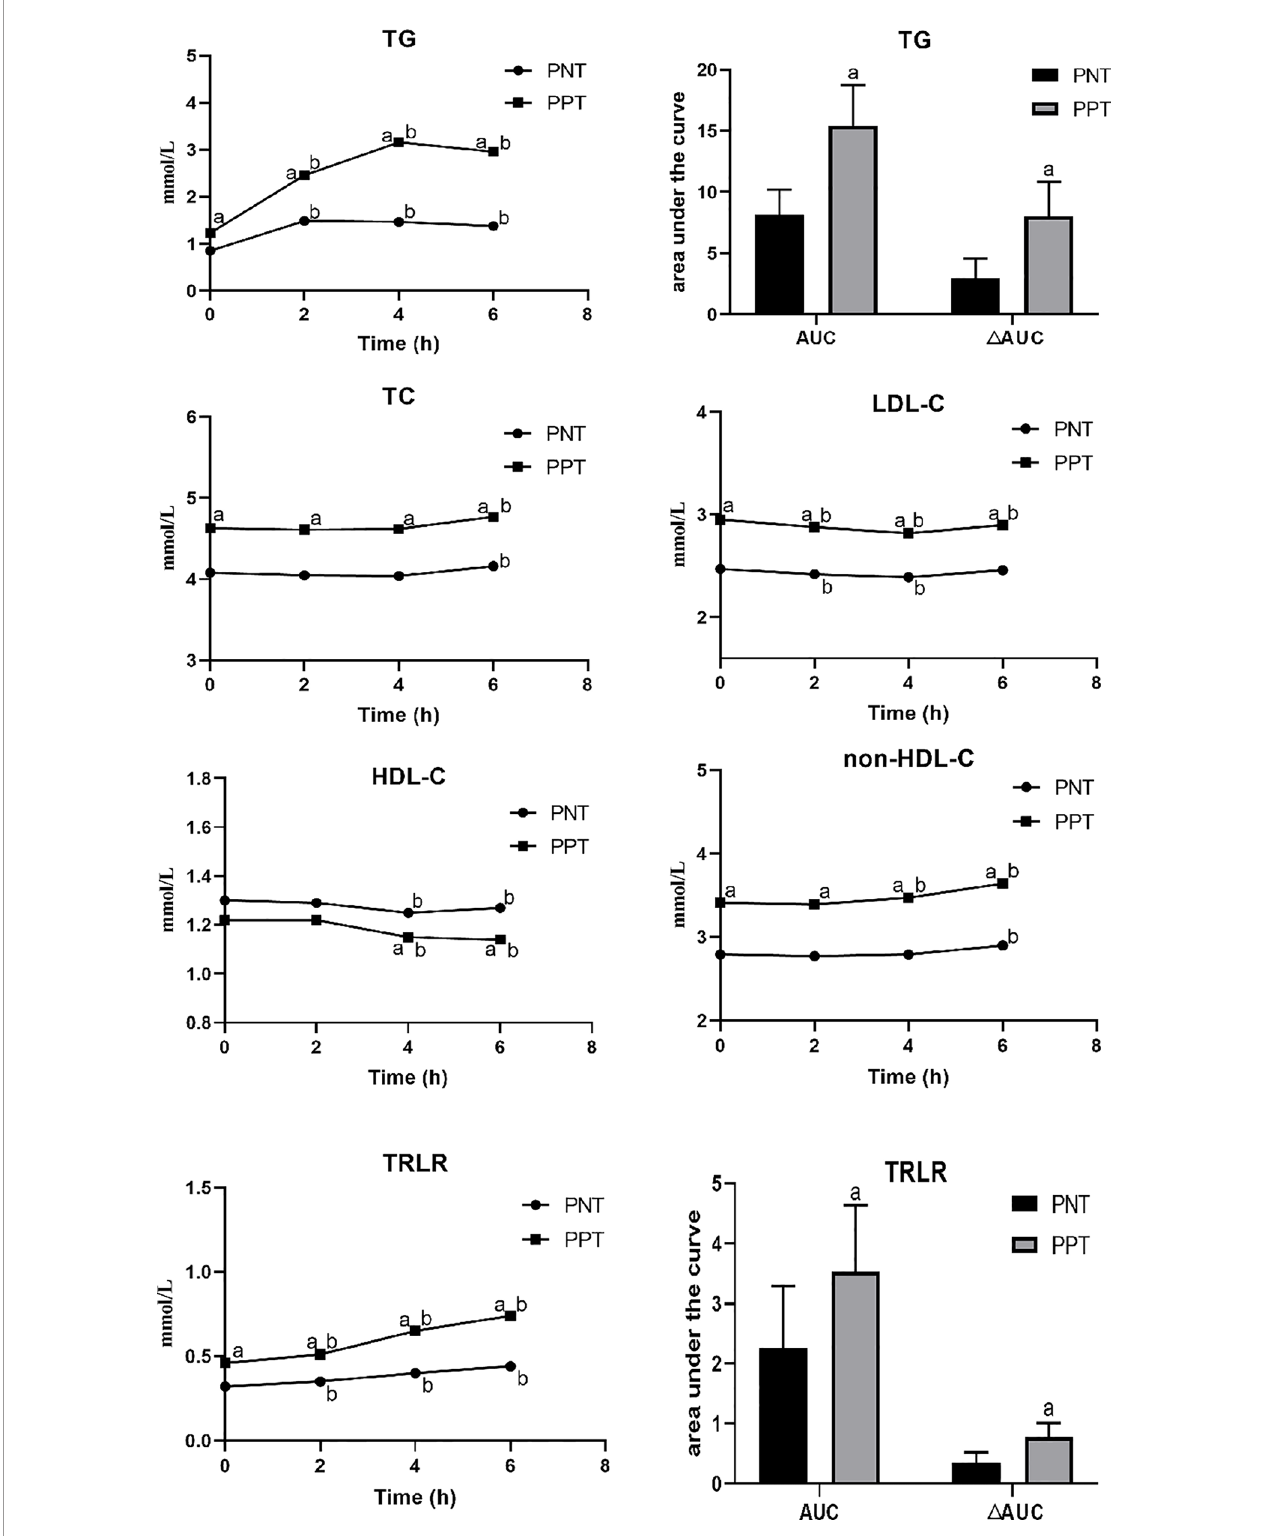
FIGURE 1 | Changes in lipid levels after a high-fat meal in the two groups. PNT, postprandial normal triglyceride; PPT, postprandial hypertriglyceridemia. a P < 0.05, compared with the PNT group; b P < 0.05, compared with the fasting level in the same